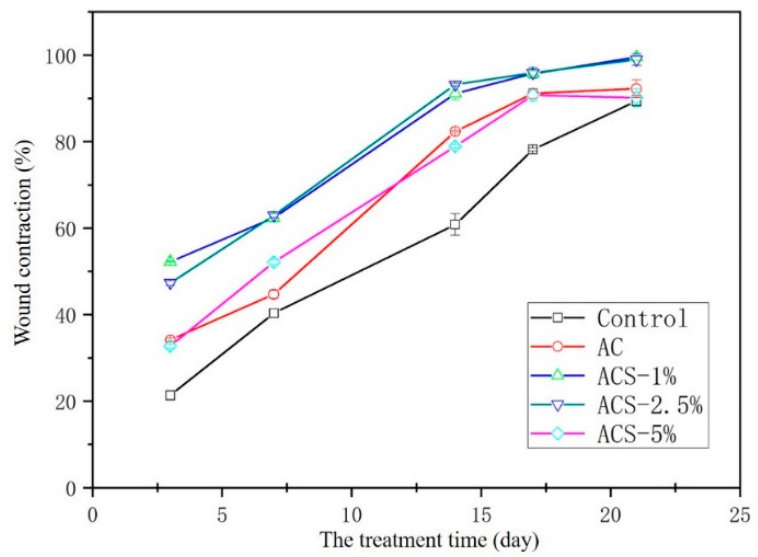
Figure 7. Wound contraction for treatment by sterile gauze (control), AC, ACS—1%, ACS—2.5%, or ACS—5% sponges.